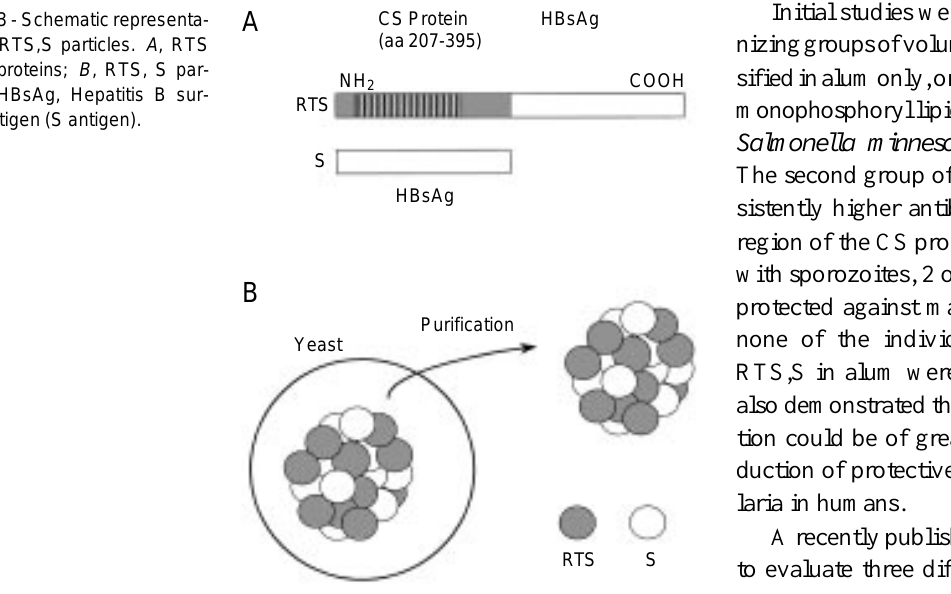
Figure 3 - Schematic representa- tion of RTS,S particles. A, RTS and S proteins; B, RTS, S par- ticles. HBsAg, Hepatitis B sur- face antigen (S